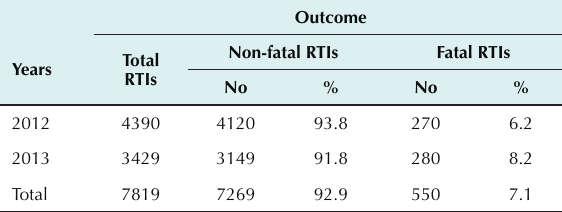
Table 2. Distribution of RTA Victims According to Accident Outcome